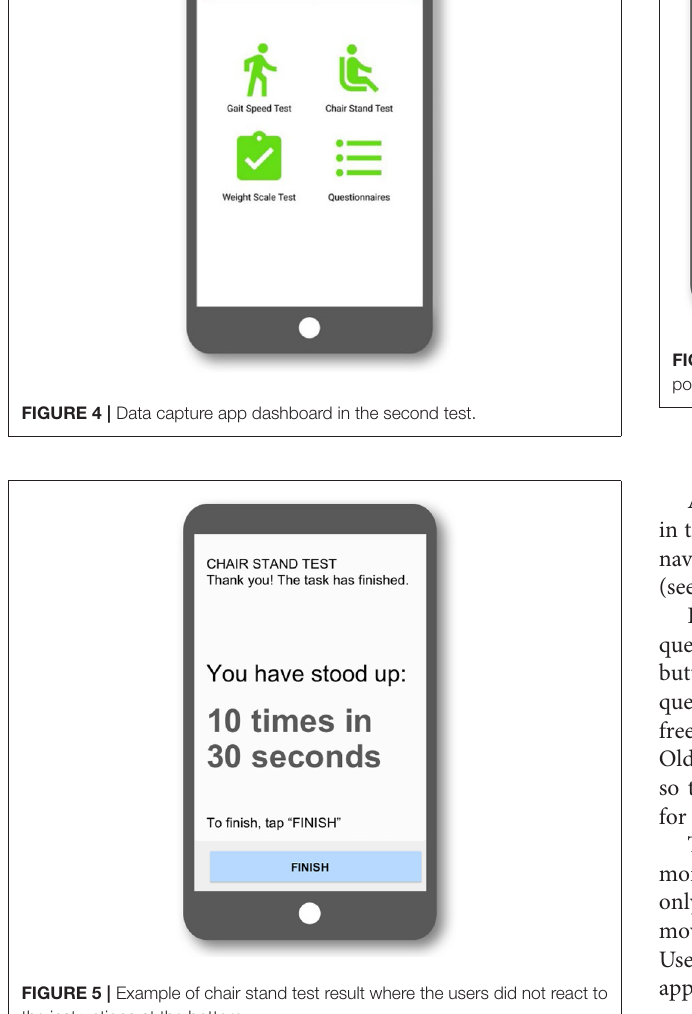
FIGURE 5 | Example of chair stand test result where the users did not react to the instructions at the bottom.